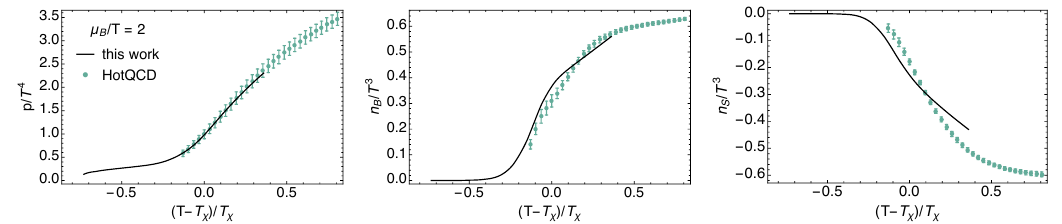
and the strangeness density B